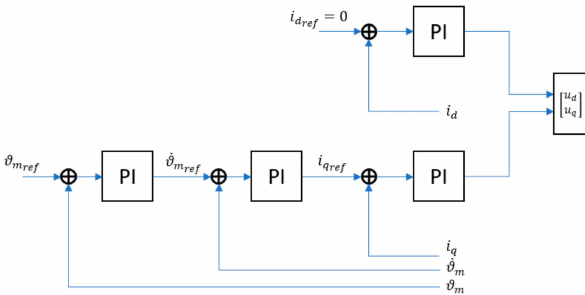
Figure 7. Classical cascade control structure. PI: